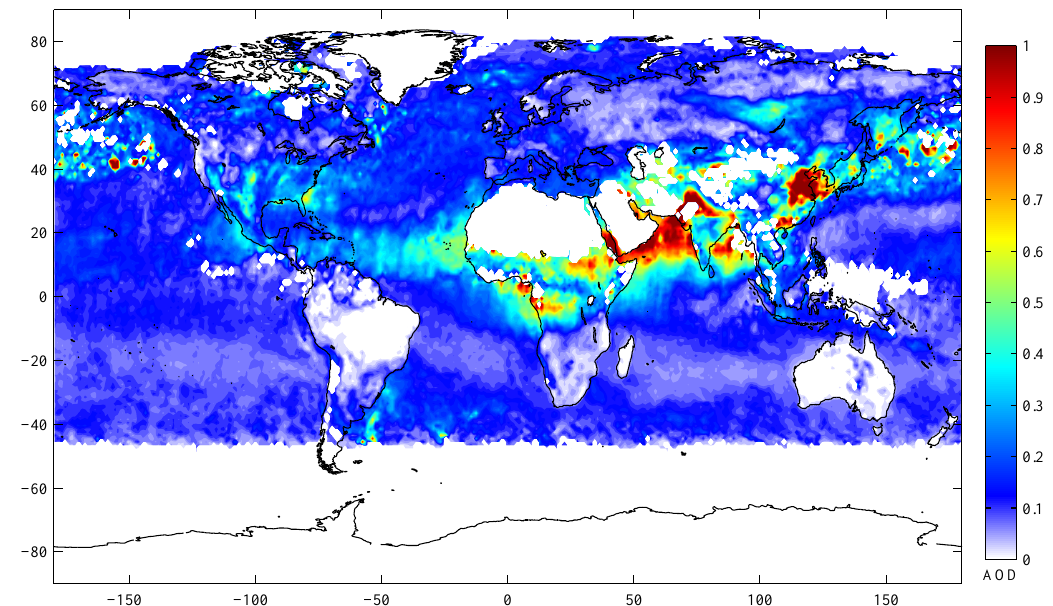
Fig. 8. Average MODIS (Terra) aerosol optical depth measurements at 550 nm for June 2011. This product is not sensitive to aerosol composition and therefore shows a variety of different aerosols and their transport patterns which can be attributed to natural aerosol (sand mainly between 0 and 30 ◦ N and ash below − 30 ◦ N), and anthropogenic (mainly urban/industrial pollution in India and Asia and biomass burning in Central Africa). This figure can be compared with Fig. 7 for the minerals and with Figure 10 for ammonium sulfate aerosol. Data downloaded from the Giovanni online data system (http://disc.sci.gsfc.nasa.gov/giovanni/overview).